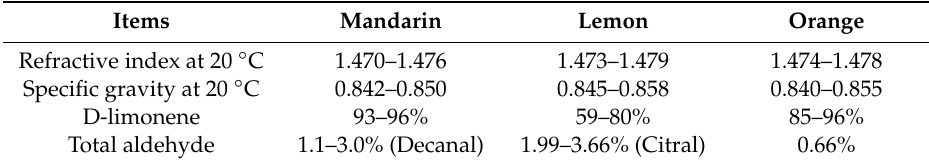
Table 1. Chemical composition of citrus essential oils.